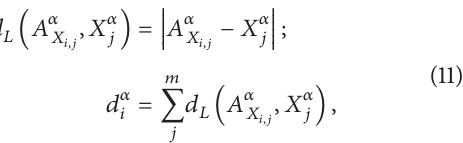
and right 𝑌 𝑟 values of the output signal. Left (𝑌 𝑙 , 𝑅 𝑌𝑙 ) and right (𝑌 𝑟 , 𝑅 𝑌𝑟 ) values are corresponding to 𝛼 = 0 level; middle , 𝑅 ) value is corresponding to 𝛼 = 1 (𝑌 𝑚 𝑌𝑚